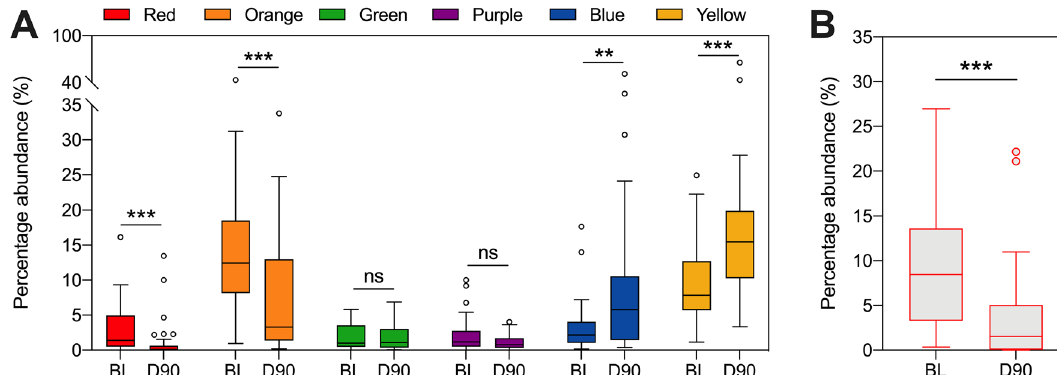
Figure 4. Comparing the abundance of health and disease associated species in the subgingival plaque. Species detected by 16S rRNA sequencing were grouped in the Socransky (1998) red, orange, green, purple, blue and yellow complexes ( A ). Comparing the sum of ‘novel’ species associated with disease identified by Perez-Chaparro (2014) ( B ). Species included in figure B are; Treponema medium, Peptostreptococcus stomatis, Prevotella denticola, Mogibacterium timidum, Filifactor alocis, Selenomonas sputigena, Alloprevotella tannerae, Anaeroglobus geminatus, Fretibacterium fastidiosum, Porphyromonas endodontalis, Treponema vincentii, Treponema lecithinolyticum and Dialister pneumosintes . Tukey box plots of all individuals (N = 42) are shown. Wilcoxon signed rank test where *** p < 0.001, * p < 0.05, ns means no significant difference. P -values were adjusted using FDR (5%).